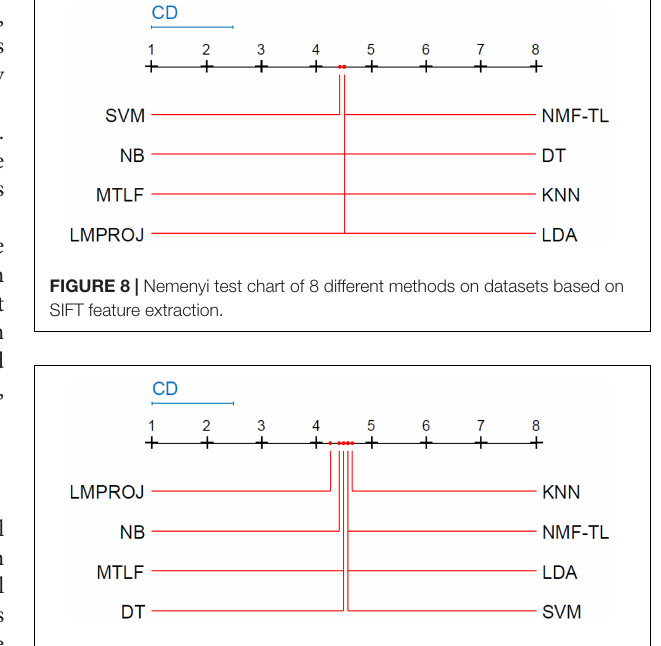
FIGURE 9 | Nemenyi test chart of 8 different methods on datasets based on KPCA feature